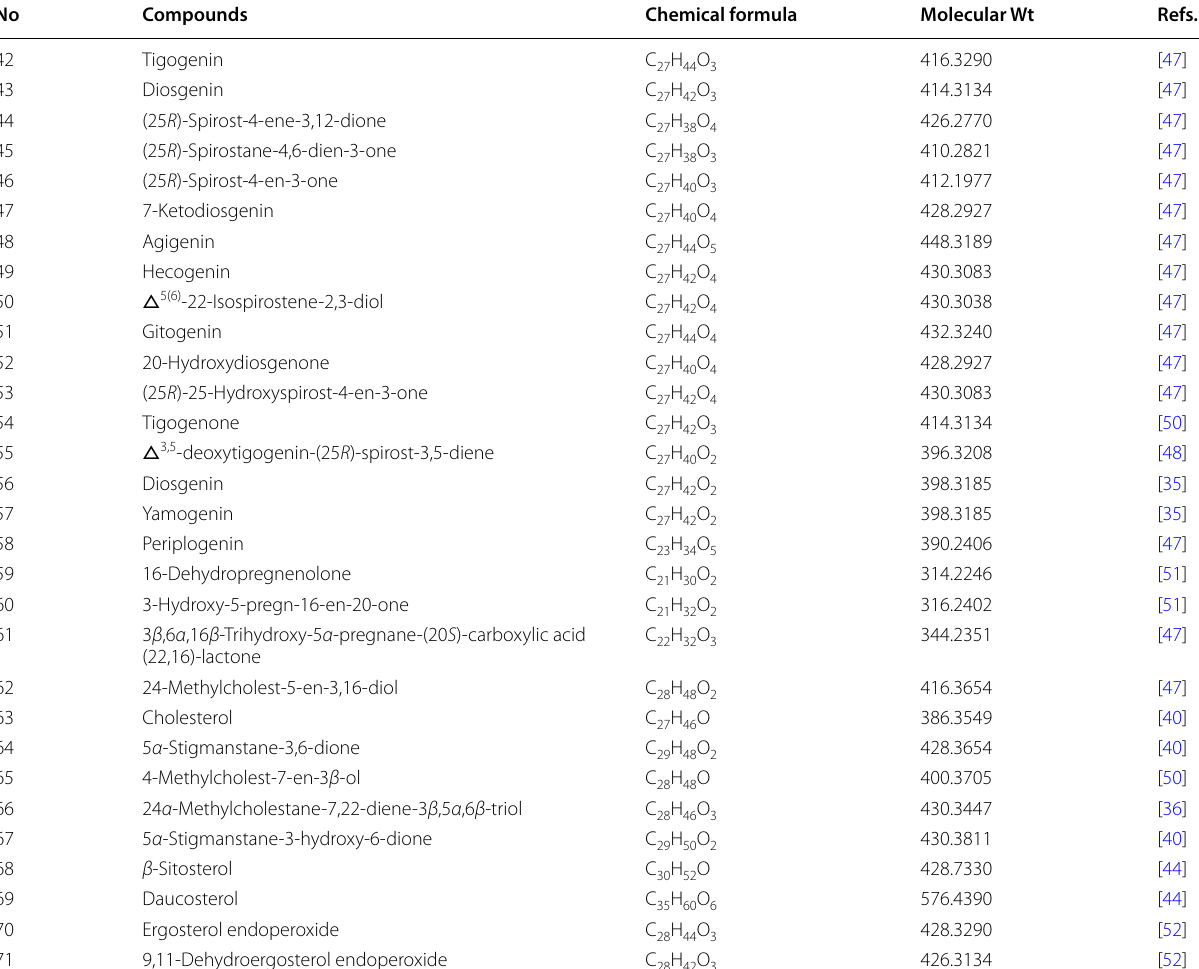
Table 4 Steroids isolated from S. lyratum